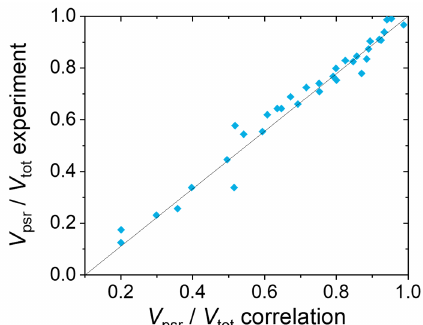
Figure 3. Correlation results for the estimation of the recirculation zone of the reactor network.